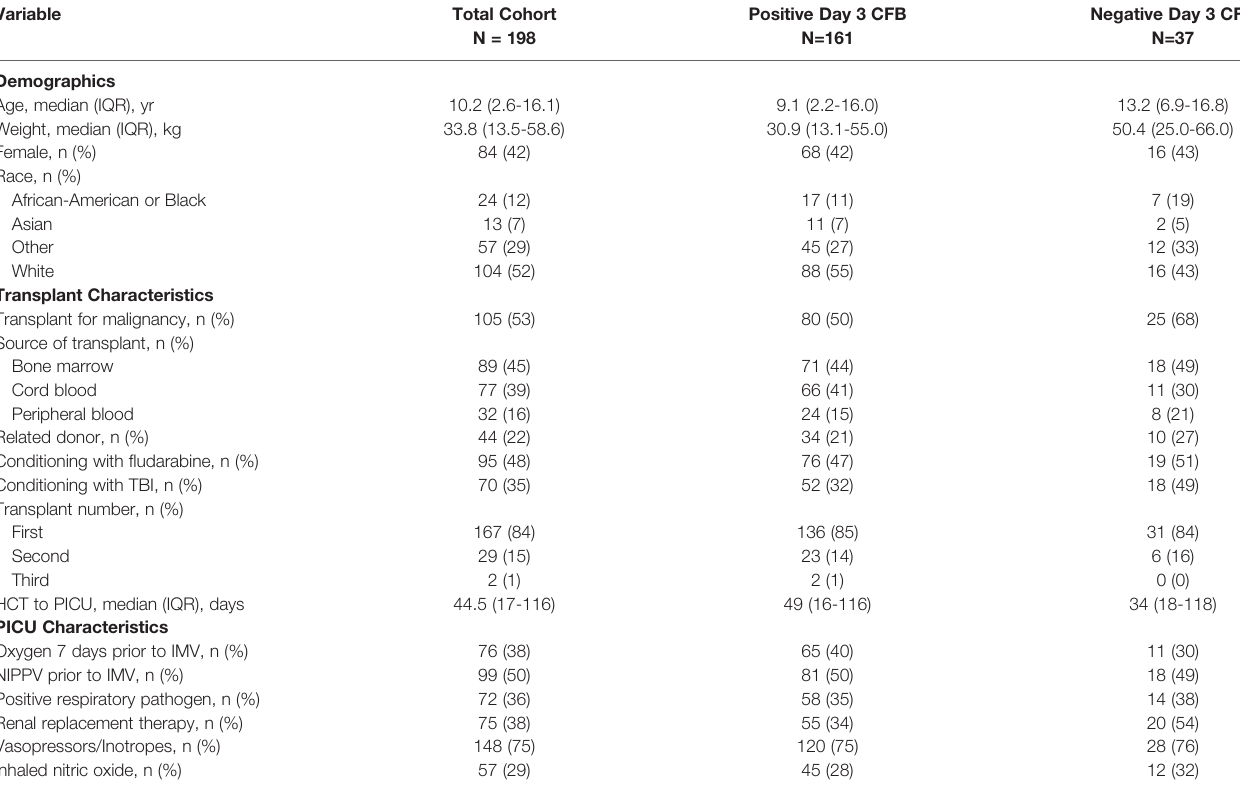
TABLE 1 | Demographic, hematopoietic cell transplant, and PICU characteristics of study population.